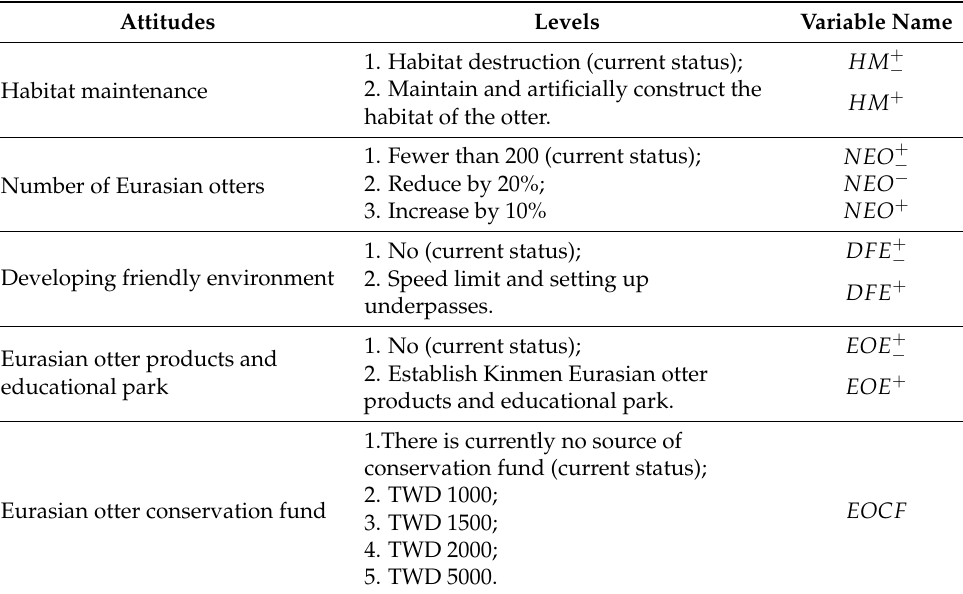
Table 1. Attributes and levels of Kinmen Eurasian otter conservation preferences.